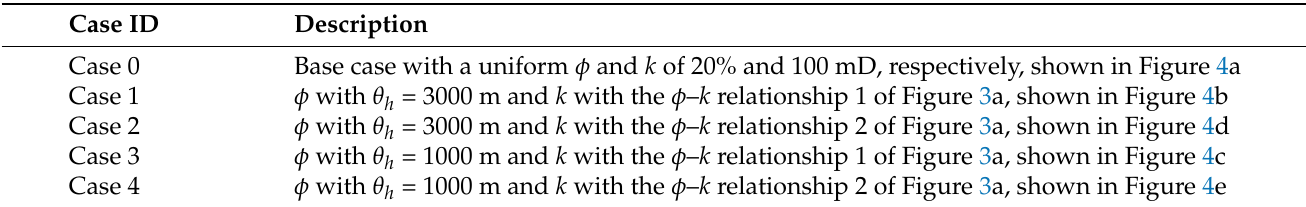
Table 1. Descriptions of the simulation cases to study the influence of the reservoir heterogeneity (cases 0 to 4).